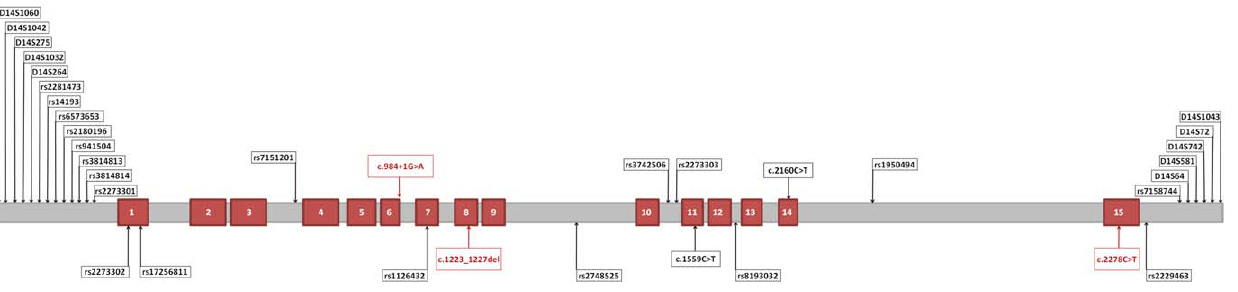
Figure 3. Schematic representation of the TGM1 gene signaling the mutations, and markers analyzed in the present study. Exons are represented as red boxes.